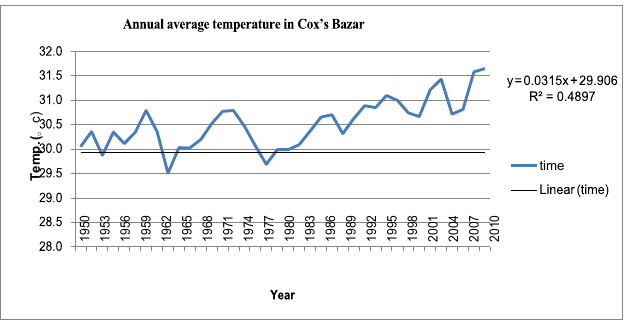
Figure 3: Long term (1950-2010) trend of annual average temperature in Cox’s